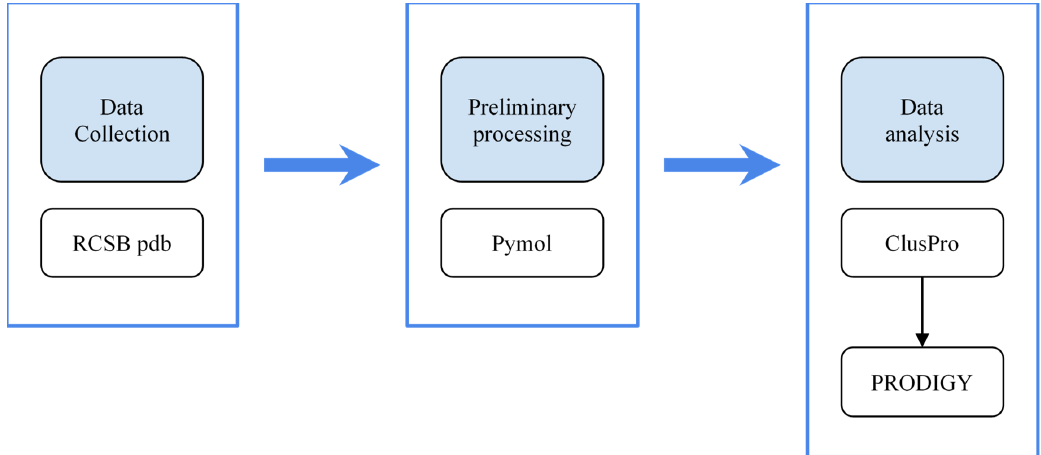
Figure 1. Workflow of the Molecular Simulation. The pipeline was taken and inspired from Arifin and Parikesit (2020); Lungidningtyas and Parikesit